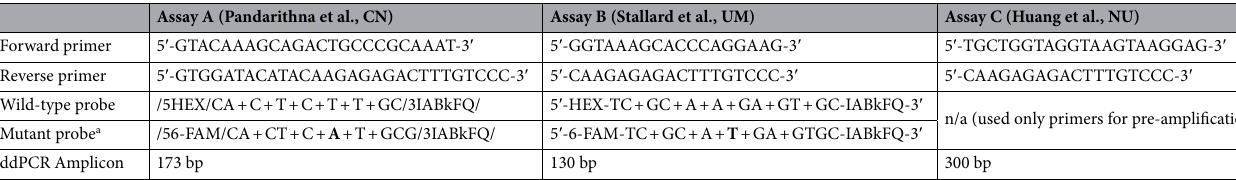
Table 1. Custom, sequence specific primers and fluorescent locked nucleic acid (LNA) probe sets utilized. HEX hexachlorofluorescein, 6-FAM 6-carboxyfluorescein, IABkFQ Iowa Black FQ quencher. a Mutant base is bold, “ + ” denotes LNA